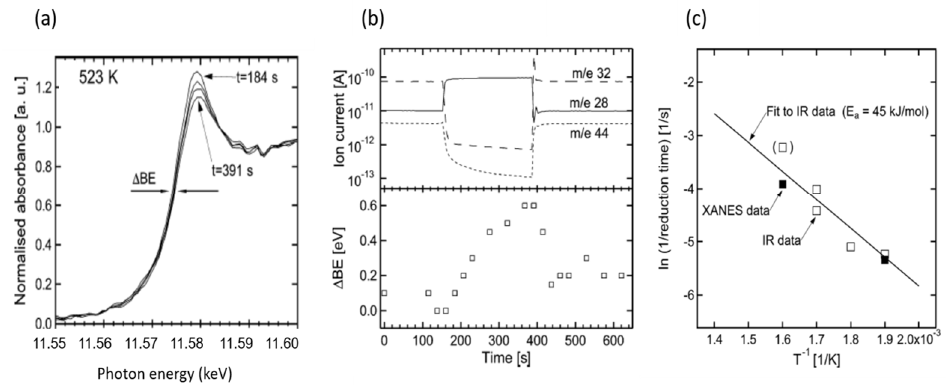
Figure 3. ( a ) Pt L 3 -edge energy dispersive X-ray absorption spectroscopy using the near-edge (XANES) derived during the switching from flowing CO/Ar to O 2 /Ar feeds at 523 K over a 2 wt % Pt/Al 2 O 3 catalyst. ( b ) Correlation of the response in MS of O 2 (32), CO (28) and CO 2 (44) (top panel) with the binding energy shift observed in the Pt L 3 -edge (bottom panel) measured at 523 K during a switching event. ( c ) Arrhenius plots for the reduction of 2 wt % Pt/Al 2 O 3 under 1% CO/Ar as the a flow of O 2 /Ar is switched from 5% in Ar to 0 derived from both infrared (IR) and Pt L 3 -edge XANES data. Reproduced with permission from J. Catal. 2004 , 226 , 422–434 [94]. Copyright 2004, Elsevier.